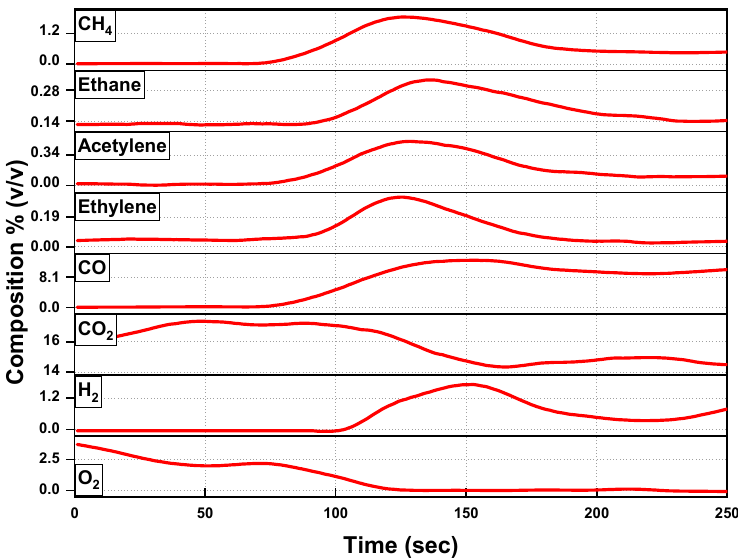
Figure 5. Figure 5. Evolved components in the gas composition from the gasification of flame retardant cotton pellets.